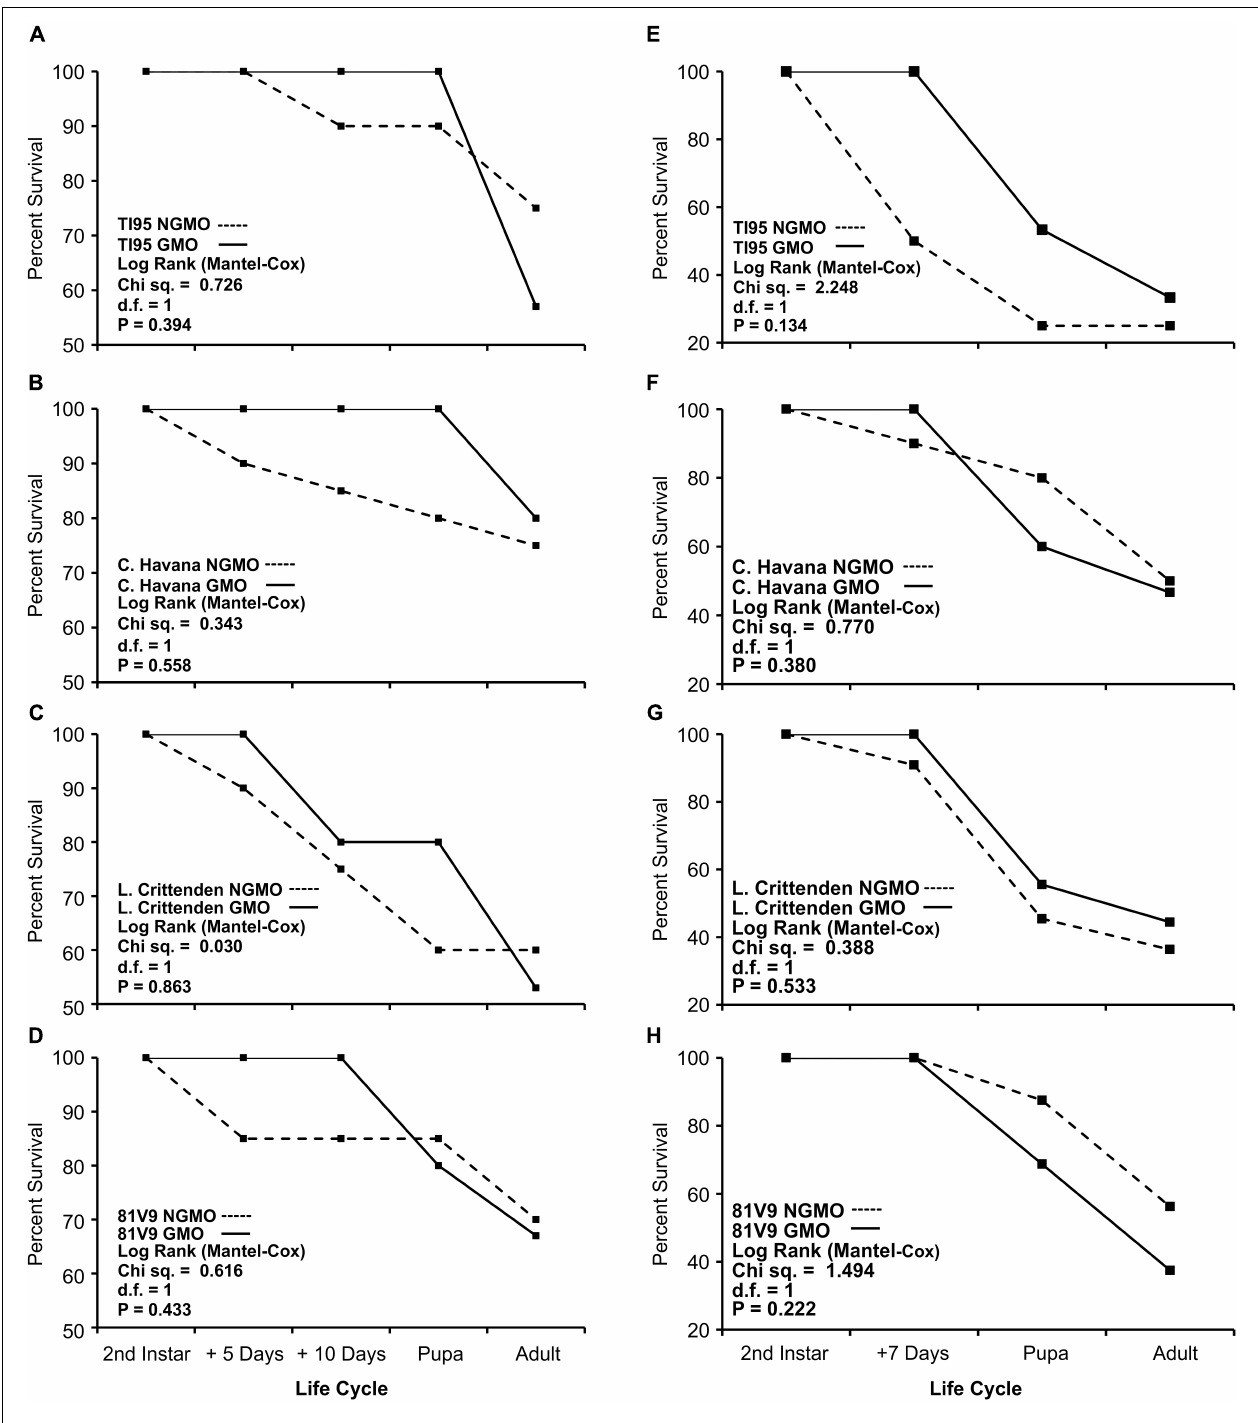
FIGURE 2 | PFA has no effect on tobacco hornworm survival. Survivorship of hornworm from larvae to adult stage on GM vs. NGM tobacco. (A–D) Greenhouse conditions and (E–H) field conditions ( N = 20 larvae/cultivar). No significant differences between GM and NGM plants were found (Kaplan-Meier, P > 0.05).